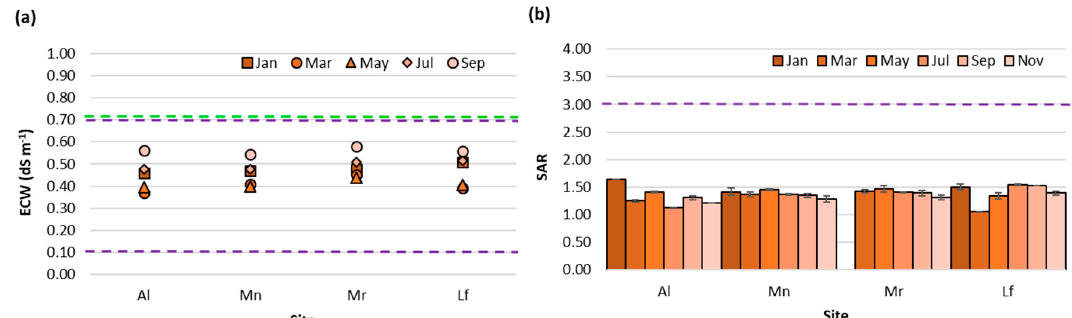
Figure 6. Spatial and temporal variation of EC W ( a ) and SAR ( b ), during 2018, at the Alqueva reservoir. Dots represent single in situ measurements. Bars represent mean and whiskers represent the standard deviation for three repetitions Dashed lines correspond to the limit values from FAO water quality standards, as presented in Table 4 (green dashed line is the limit value for salinity problems and purple lines are the limit values for infiltration problems). Al— Á lamos; Mn—Montante; Mr—Mour ã o;